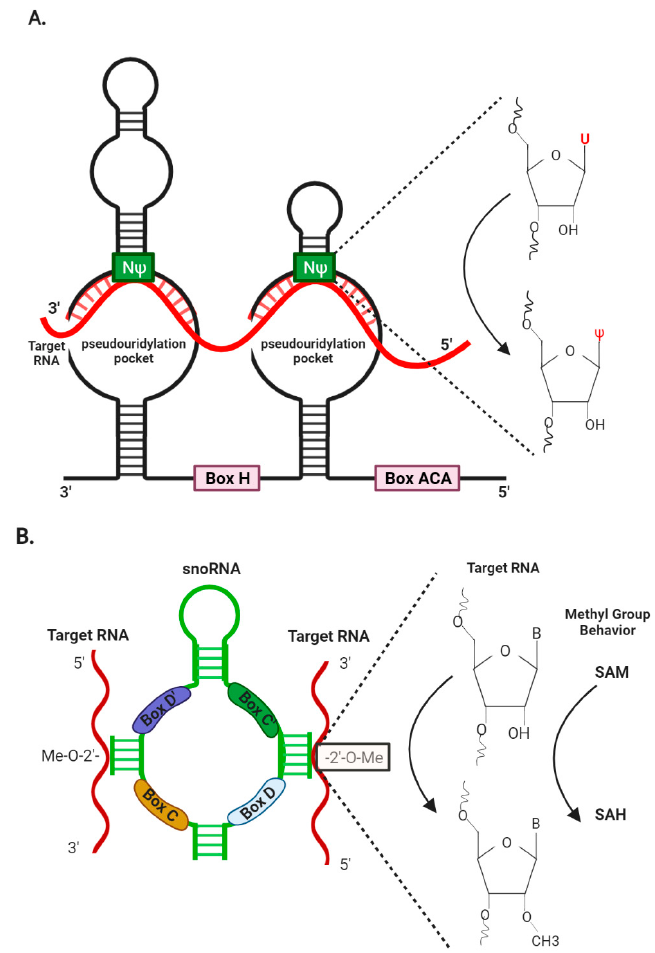
Figure 2. snoRNA modulation of RNAs. snoRNAs contribute to HCC progression through interac- tions with target RNAs. ( A ) H/ACA box snoRNAs modify target RNAs by converting the nucleoside uridine into pseudouridine. The conserved motives H box (ANANNA; N for any nucleotide) and ACA box (ACA trinucleotide) form the characteristic “hairpin–hinge–hairpin–tail” structure with two pseudouridylation pockets, where the target RNA is isomerized. The pseudouridylation pockets contain 9–13 nucleotides complementary to the target RNA that flank the uridylation side. The H box motive is positioned in the hinge region and the ACA box motive close to the 3 (cid:48) -terminal region. ( B ) C/D box small nucleolar RNAs (snoRNAs) modulate target RNAs by transferring a methyl group, termed a 2-O’-ribose-methylation. S-adenosylmethionine (SAM) serves as methyl group donor to S-adenosylhomocysteine (SAH). C/D box snoRNAs contain conserved box C (PuUGAUGA) and box D (CUGA) motives and less conserved C’ box and D’box motives. The molecule forms a “kink-turn” (stem-bulge-stem) structure that brings the C box and the D box motives in proximity that is essential for the snoRNA function. The enzyme Nop1p (fibrillarin)catalyzes the shift of the methyl group to the complementary target RNA, bound to the snoRNA. Reprinted with permission from BioRender.com. Copyright 2022